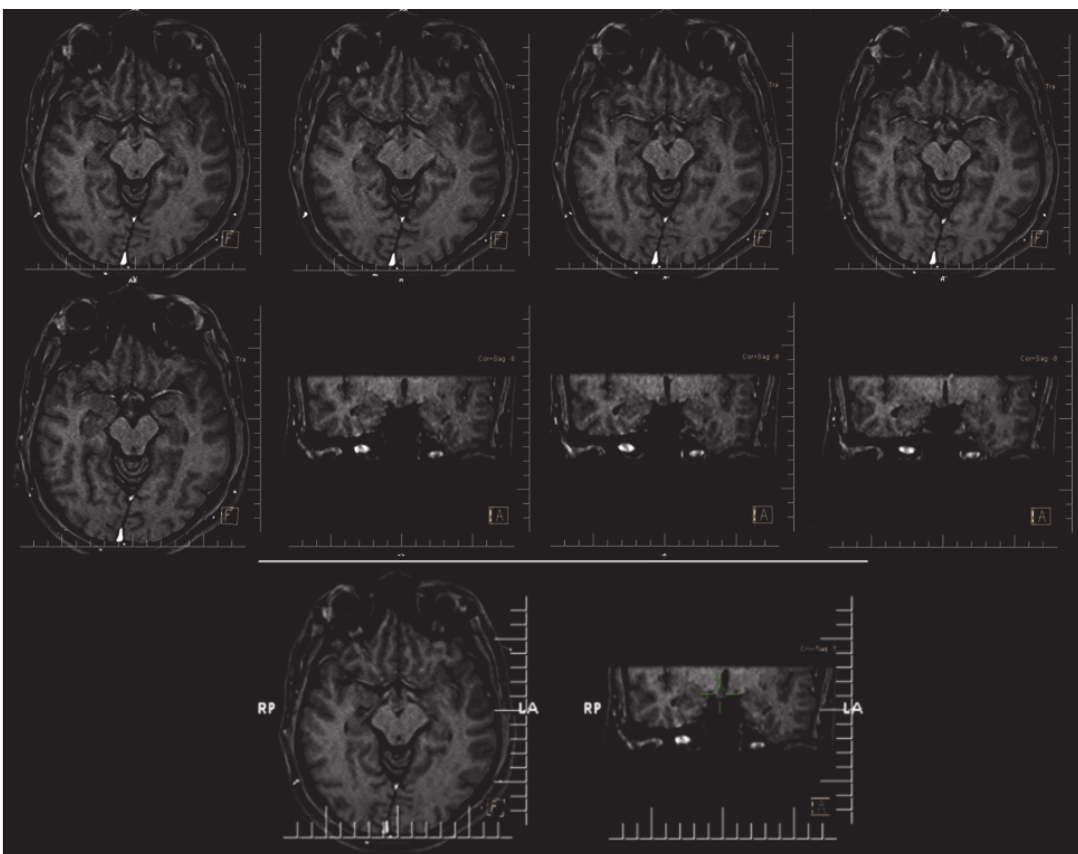
Figure 3: MRI of the patient revealing hypothalamic